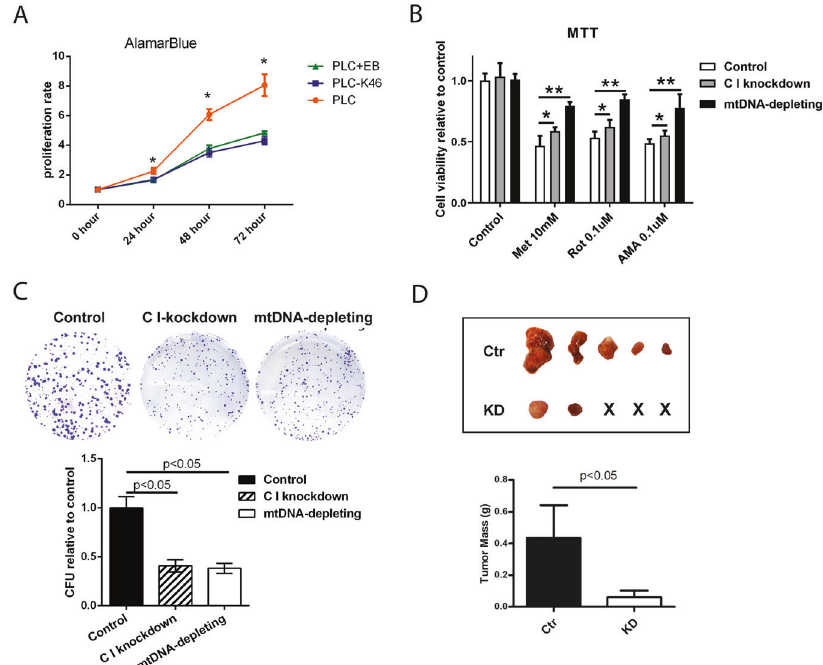
Fig. 4 Compromising mETC integrity inhibits HCC cell growth in vitro. A Alamar Blue assays measure the cell growth rates in different liver cell lines (PLC/PRF/5, C I knockdown, and mtDNA depleting) were performed ( N = 8). B MTT assays to test the mETC complex I and III inhibitors (Met, ROT, and AMA) effect on the proliferation of the three cell lines ( N = 9). C Representative images of colony formation assay of PLC/PRF/5, C I knockdown, and mtDNA-depleting HCC cells, and the colony formation units (CFU) were calculated. The results were normalized to